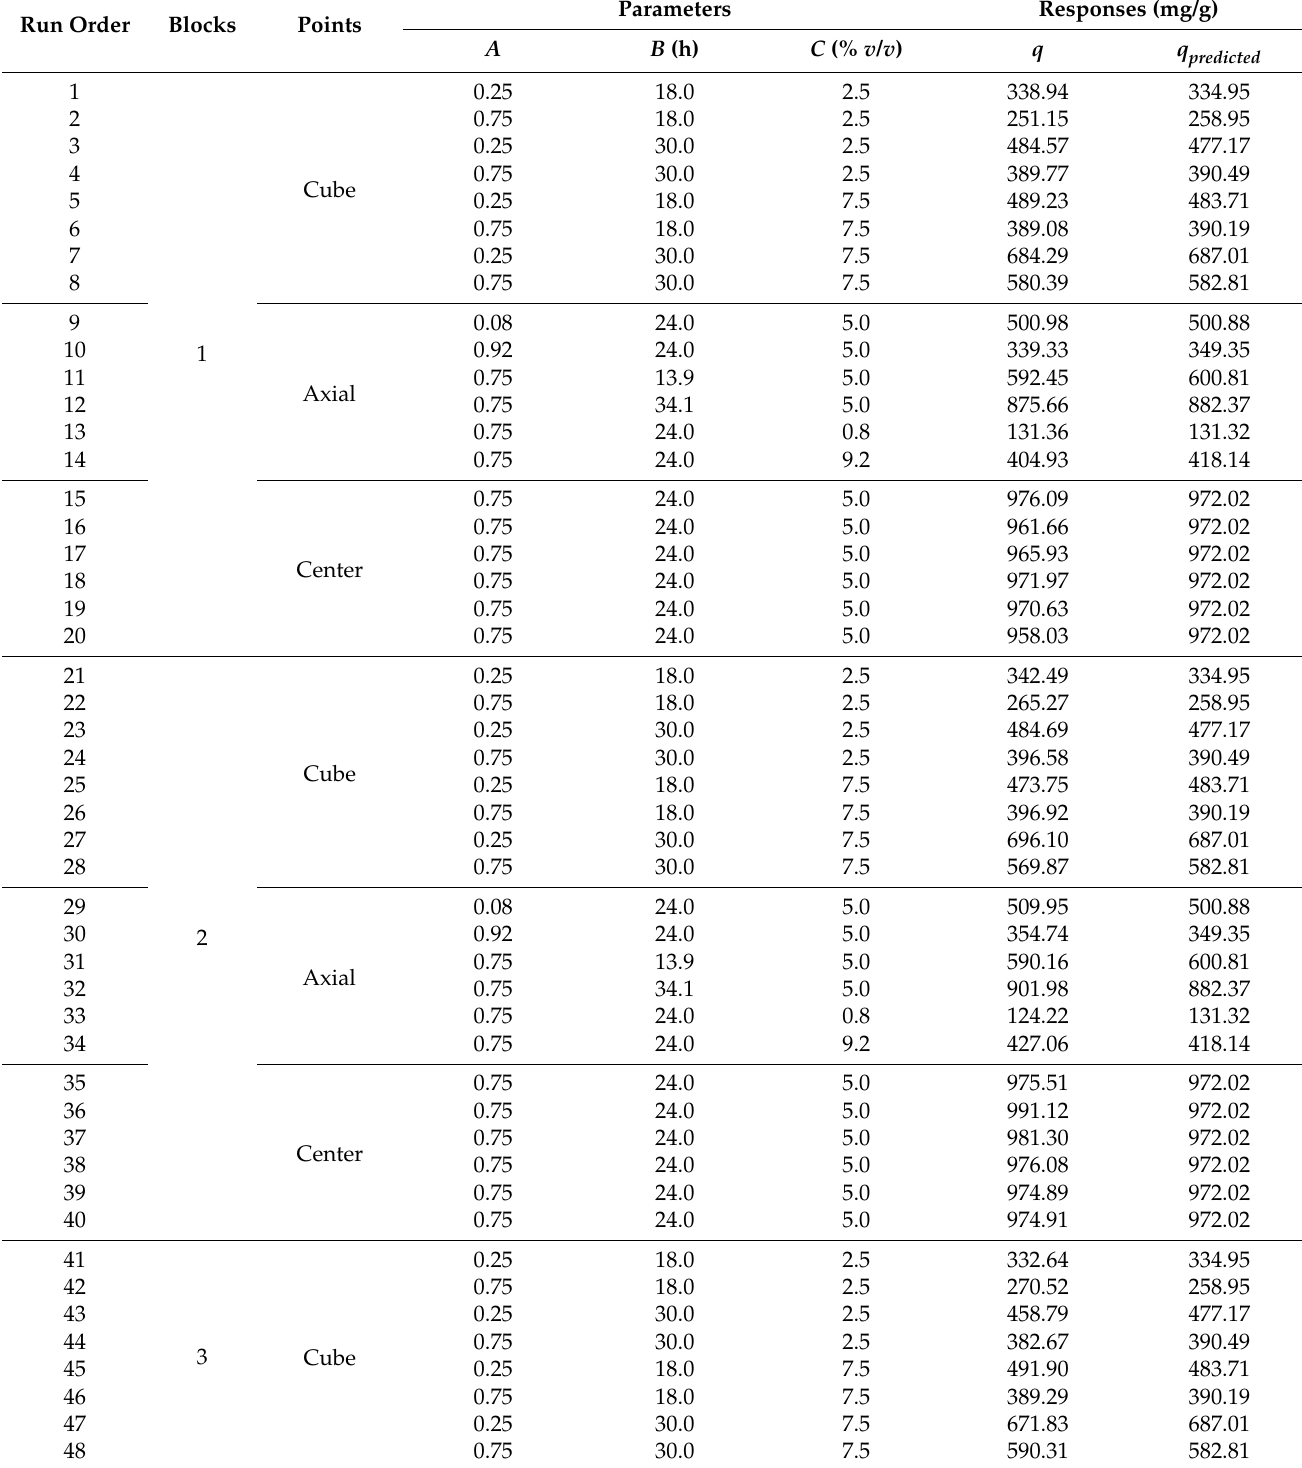
Table 1. Actual and predicted responses based on experiments designed with CCD of